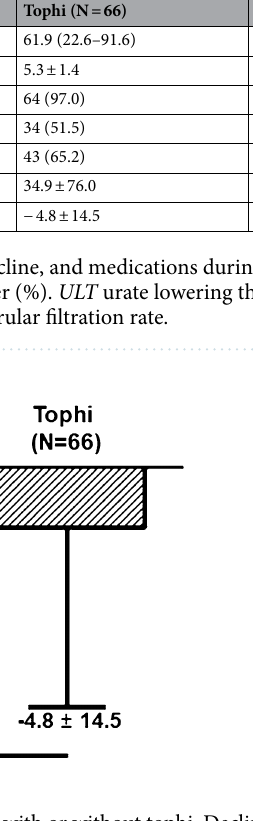
Figure 1. Changes in eGFR in gout patients with or without tophi. Decline of the eGFR in the tophi group was − 4.8 ± 14.5 ml/min/1.73m 2 /year, while that in the no tophi group was − 0.7 ± 11.9 ml/min/1.73m 2 /year ( P = 0.039).